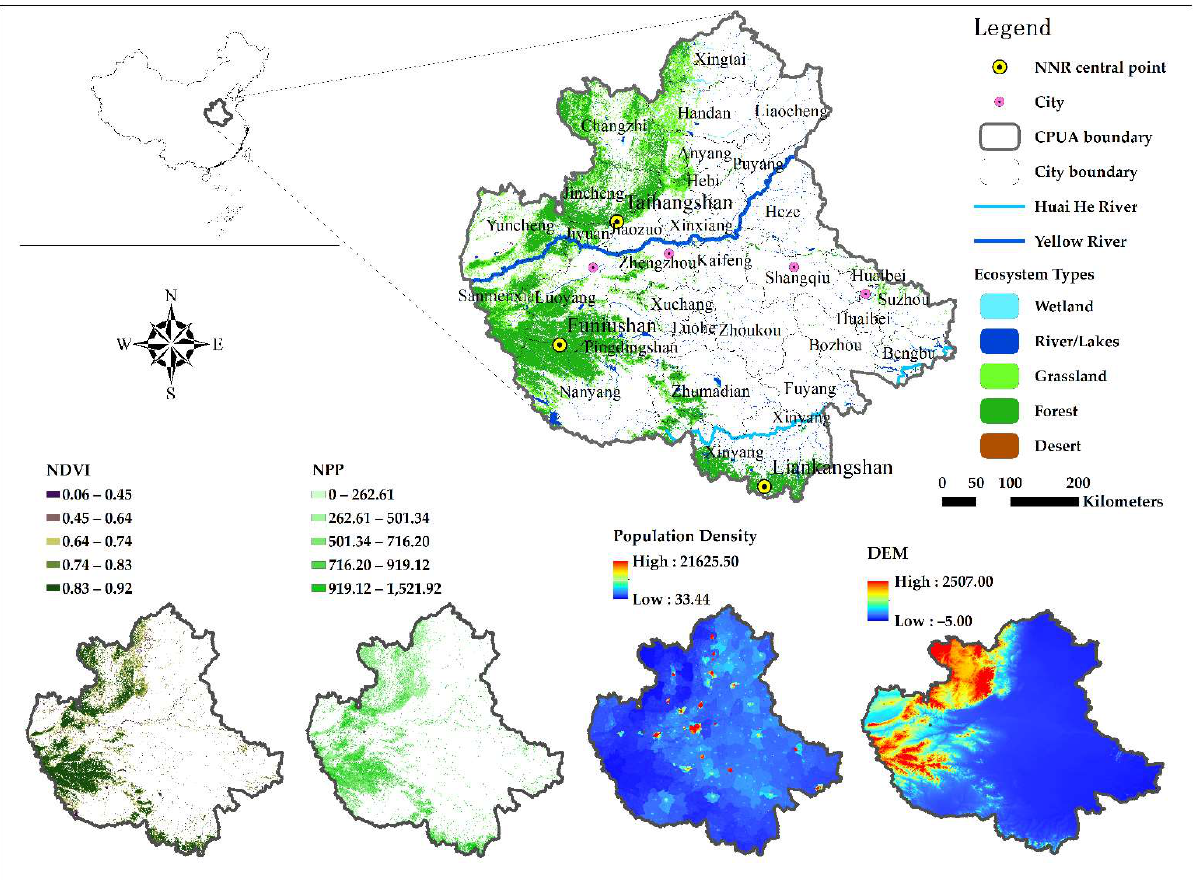
Figure 1. The location, the DEM, population distribution, ecosystems, and ecozone in the ecospace of CPUA.